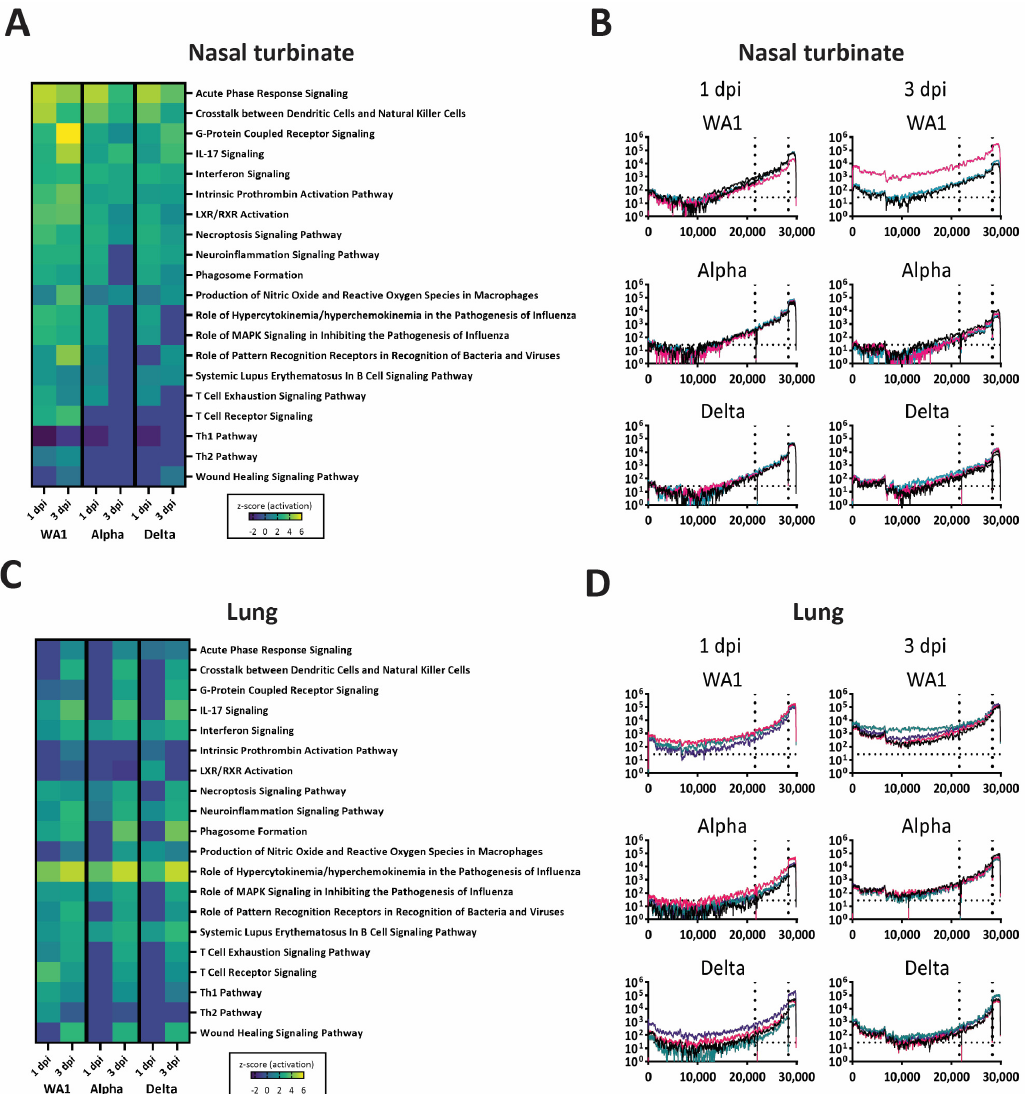
Figure 6. Heatmap of activated pathways and viral RNA levels in nasal turbinates and lungs from high dose of WA1-, Alpha-, or Delta-infected mice. ( A , C ) Heatmap illustration of the activated pathways in mice infected with 2.5 × 10 4 PFU of WA1, Alpha, or Delta as compared to PBS-inoculated at 1 and 3 days postinfection (dpi). Canonical pathways are displayed on the right and group specifications are listed below. The dpi is listed at the bottom of each heat map. As described in the Materials and Methods section, the reads from RNASeq data were mapped to Mus musculus and the SARS-CoV-2, gene counts were assessed in DESeq2, and only those genes with a log 2 fold change of ± 1.5 with an FDR ≤ 0.05 were evaluated in Ingenuity Pathway Analyses software. RNA-seq data of each viral genome were graphed to show the depth of coverage (Y-axis) by nucleotide position (X-axis) on the SARS-CoV-2 genome for nasal turbinate ( B ) and lung ( D ) samples. In each graph, the vertical dotted line marks the beginning of the subgenomic region, the start of the spike encoding region. Second vertical dotted line marks the beginning of the nucleocapsid encoding region. The horizontal dotted line represents the limit of detection. Legend: Z-scores are from dark purple (lowered) to yellow (heightened), as illustrated. Each colored line represents the results from one mouse.